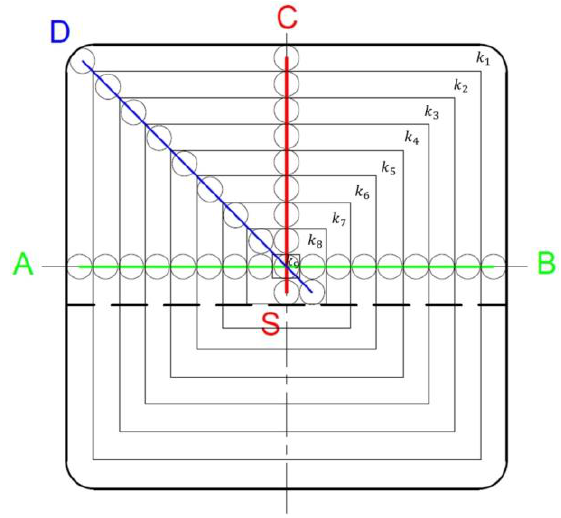
Figure 6. Layout of measurement points on the billet cross-section and division of the cross-section area into 9 zones.